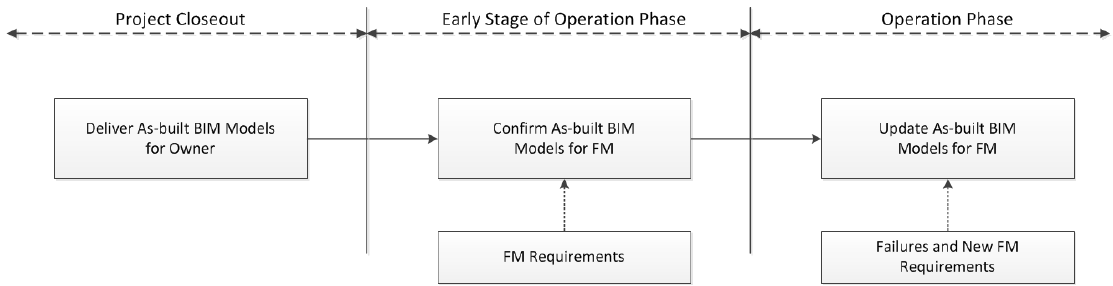
Figure 1. The process of the as ‐ built Building Information Modeling (BIM) models delivered to update as ‐ built BIM models for facility management (FM).